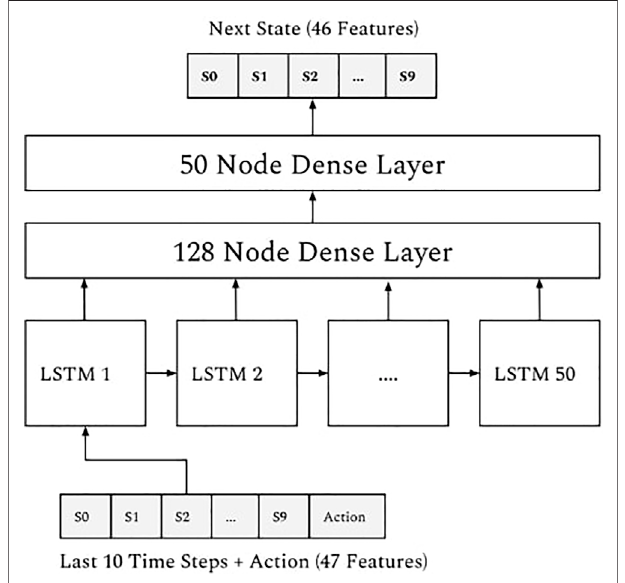
FIGURE 4 | Neural architecture of